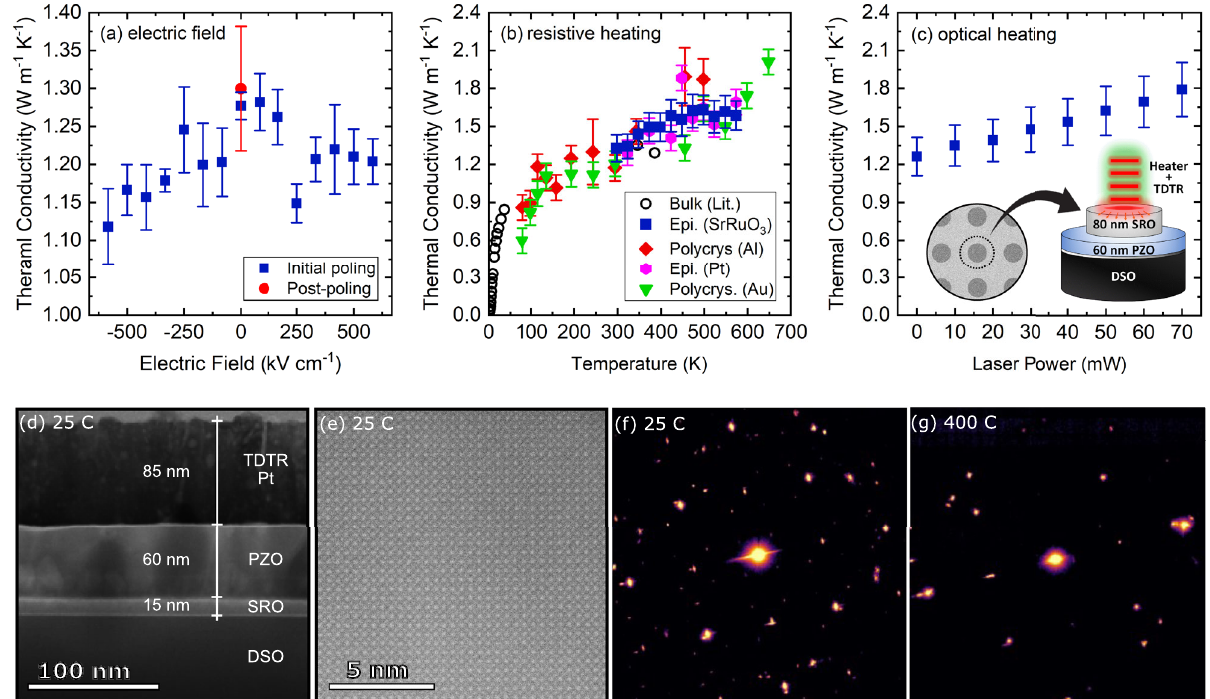
Fig. 4 Thermal conductivity of PZO upon phase transformation as a result of electric fi eld and thermal stimuli. a Thermal conductivity as a function of electric fi eld for PZO measured at room temperature. b Thermal conductivity as a function of temperature, measured on a resistive heating stage. The uncertainty in ( a , b ) is based on standard deviation across multiple scans. c Thermal conductivity as a function of laser power. The uncertainty in ( c ) is calculated based on 10% variations in the transducer thickness, and the inset shows the schematic of the layers con fi guration studied here. d Annular bright- fi led STEM image showing the corresponding layers in the epitaxial PZO at room temperature, ( e ) and the high-resolution TEM showing the high degree of order in the studied sample. Selected-area diffraction patterns of epitaxial PZO at ( f ) 25 °C and ( g ) 400 °C showing that our PZO fi lm has undergone a phase transition from orthorombic space group Pbam to cubic Pm (cid:1) 3 m (see Supplementary Note